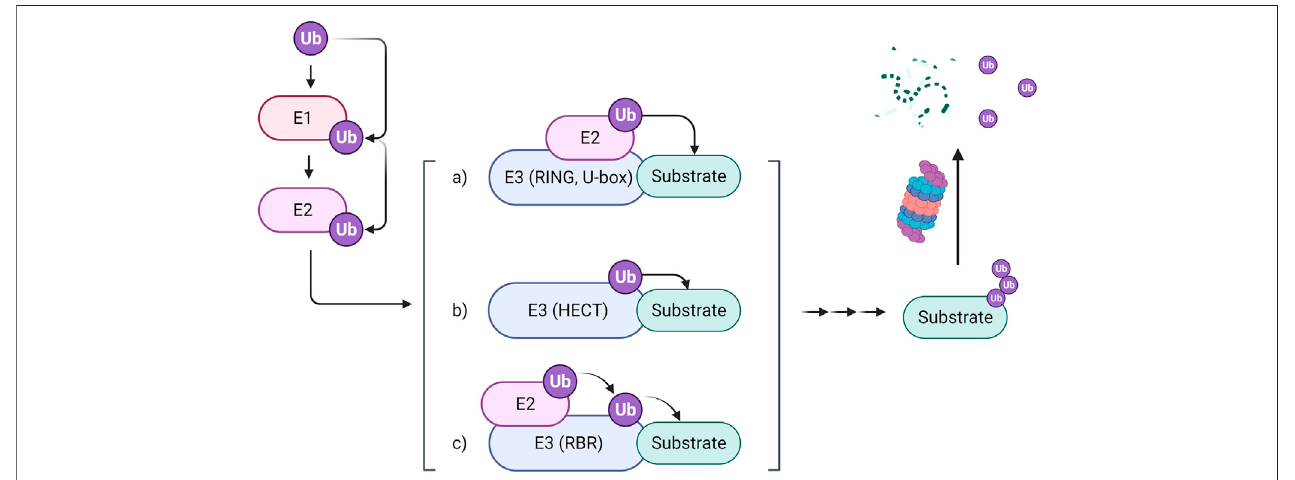
FIGURE 1 | The mechanism of the ubiquitin-proteasome system. The ubiquitin-proteasome system comprises three types of enzymes. The ubiquitin-activating enzyme E1 binds with ubiquitin and then transfers it to the ubiquitin-conjugating enzyme E2, which further cooperates with three types of ubiquitin-protein ligase E3 to transport ubiquitin to substrates through different mechanisms. Finally, the labeled substrates are recognized by proteosomes for